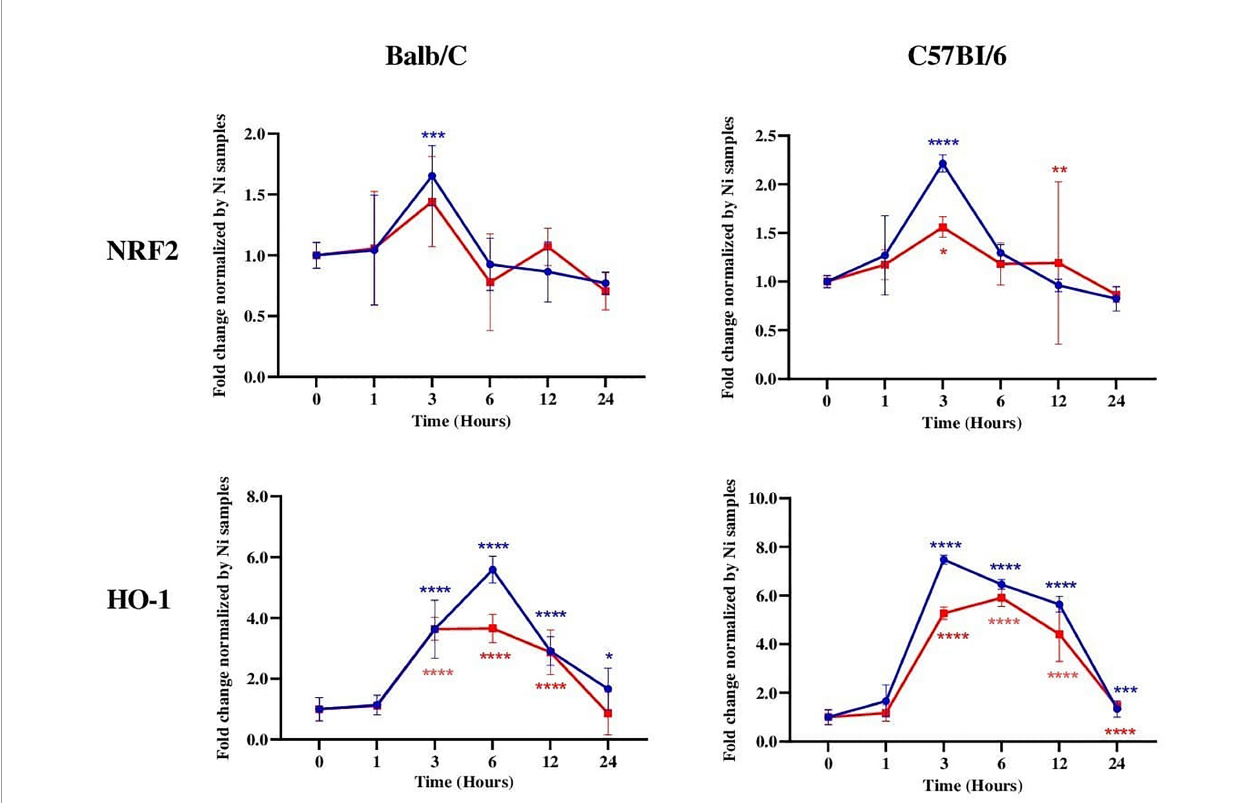
FIGURE 4 | NRF2 and HO-1 mRNAs were induced in Leishmania -susceptible and Leishmania -resistant bone marrow-derived macrophages (BMdMs). Balb/c and C57Bl6 BMdMs were infected by live parasites ( P ) ( blue fi lled circle ) or heat-inactivated ( Kp ) ( red fi lled square ) L. major promastigotes for different times. RT-PCR targeting Nrf2 and HO-1 was performed. The graphs show fold change results expressed as the mean ± SD from three independent experiments. * p < 0.05, ** p < 0.01, *** p < 0.001, **** p < 0.0001 vs . non-stimulated BMdMs (two-way